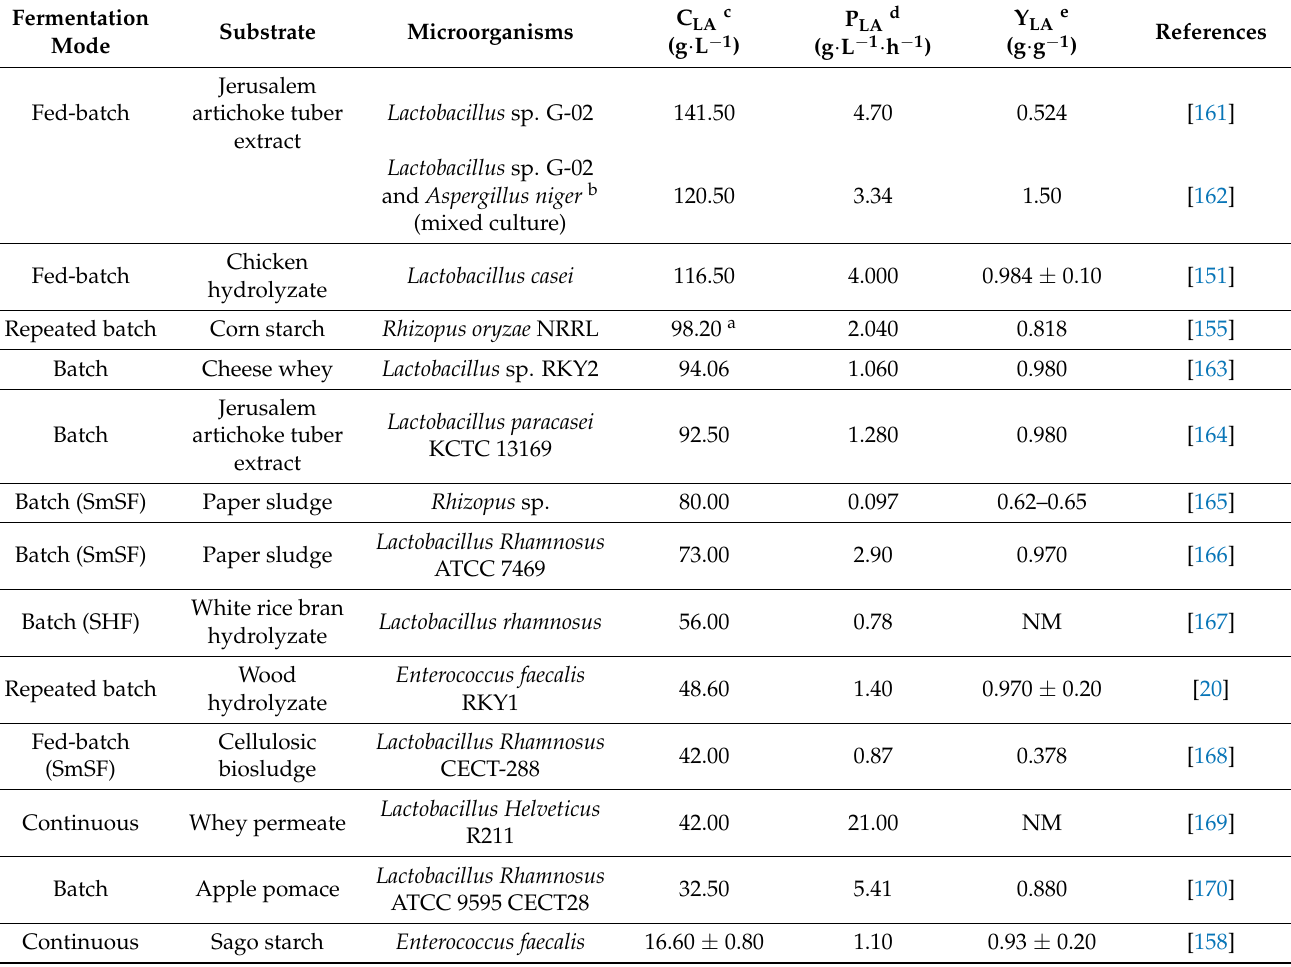
Table 4. Different fermentation modes in L-lactic acid production, concentrations, yield, and